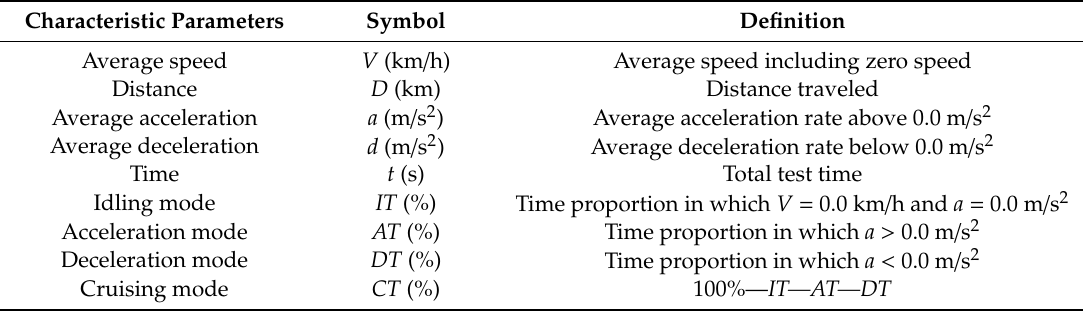
Table 2. Parameters for the characterization process—to be used following the filtering process described